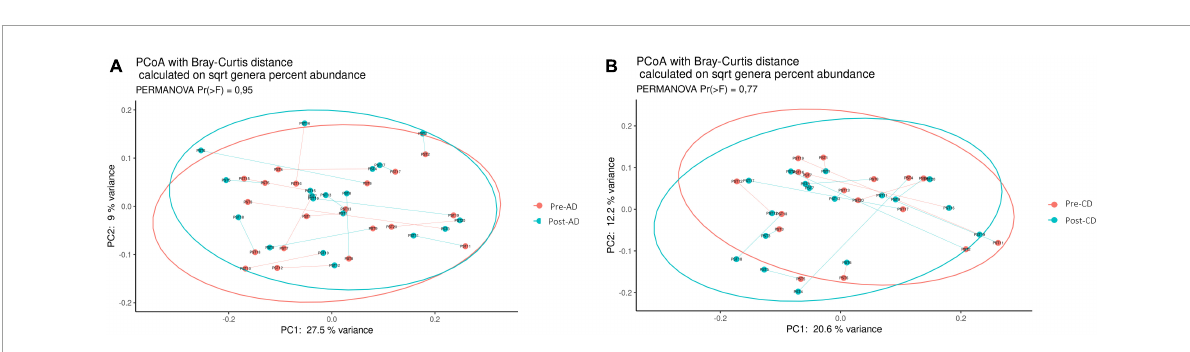
FIGURE3 Principal coordinates analysis (PCoA), according to the Bray-Curtis beta-diversity metric, of pre- and post-AD samples (A) and pre- and post-CD samples (B) . Results of the permutational multivariate analysis of variance (PERMANOVA) are also shown based on the first two coordinates. AD, ancient-wheat diet; CD, control-wheat